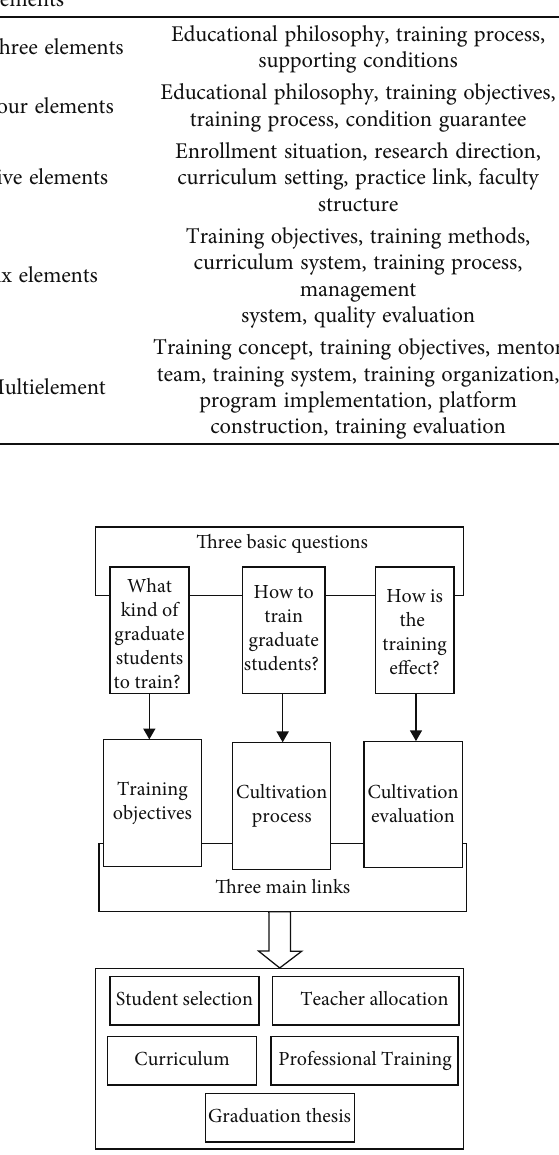
Figure 6: The selection process of the elements of the postgraduate training